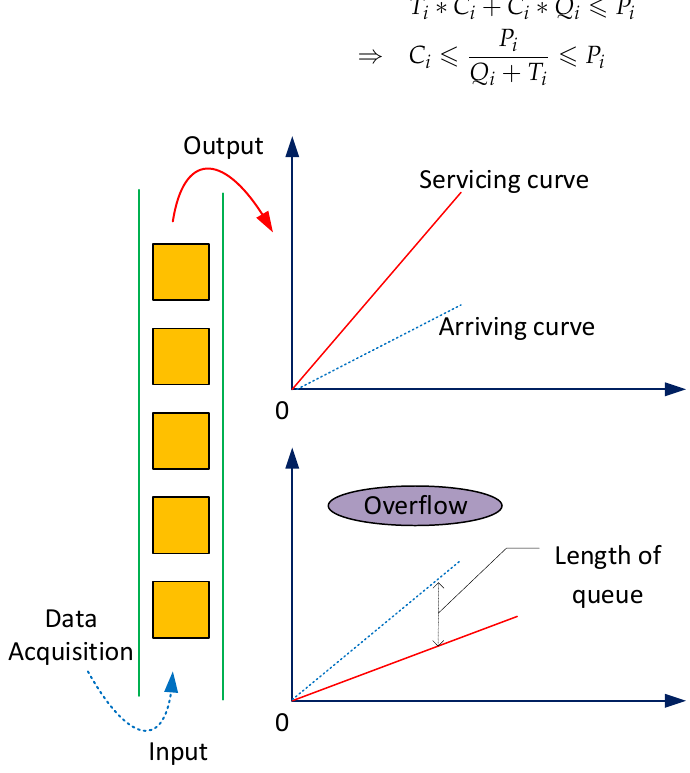
Figure 3. Sensor data buffer